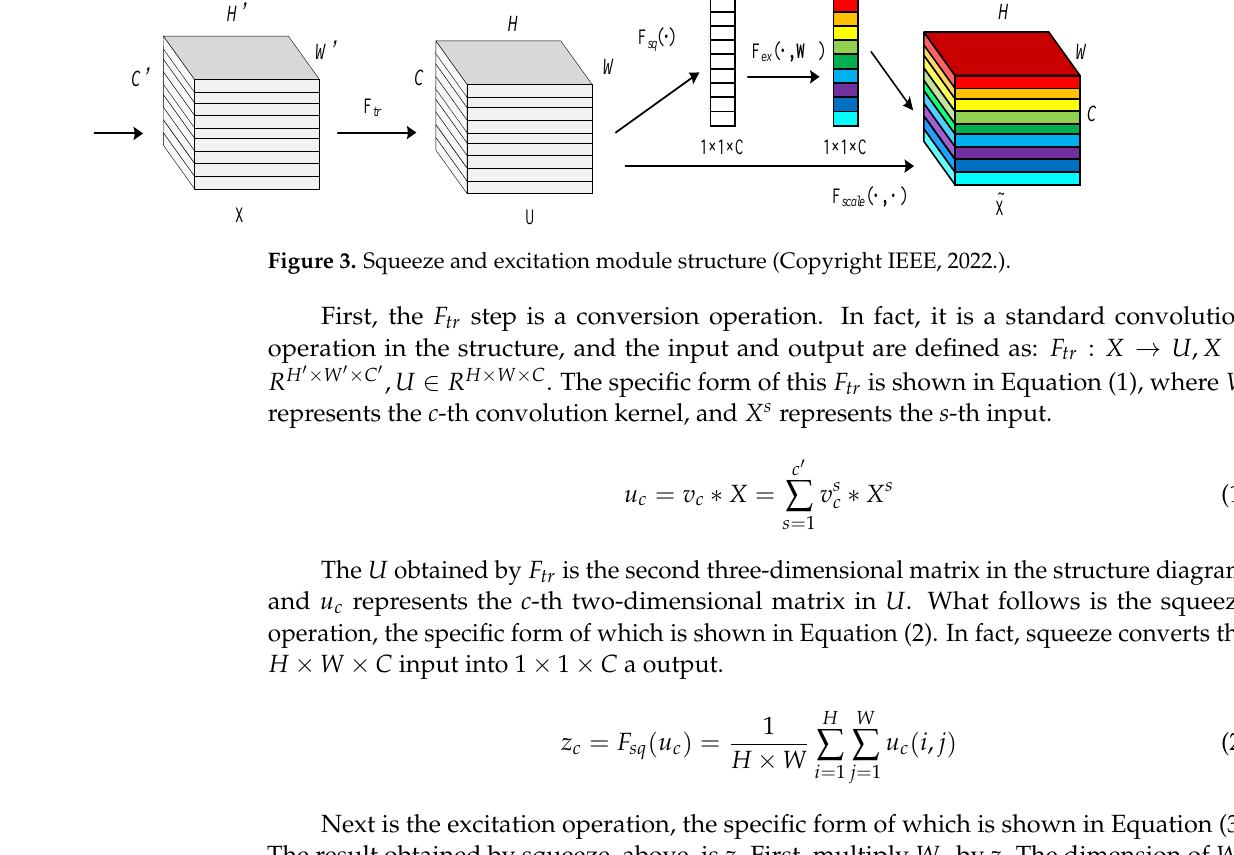
Figure 4. Optimized CSP1_X and CSP2_X module.